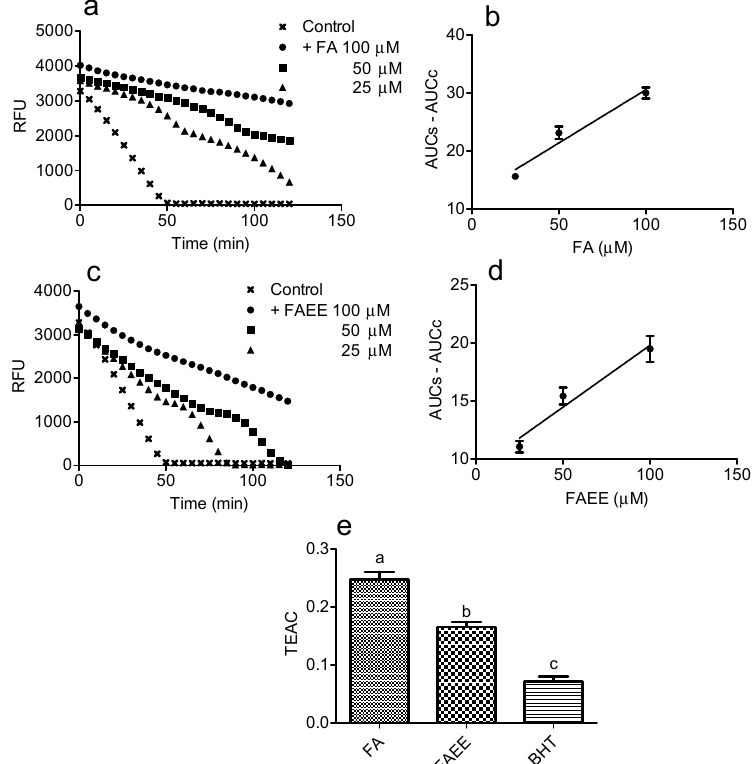
Figure 2. Scavenging activity against ROO•. ( a , c ) Kinetic profile of pyranine fluorescence bleaching by ROO• in the presence of absence of the tested compounds. ( b , d ) Linear relationship between the area under the curve and concentrations of FA and FAEE. From the liner regression curves the slopes were calculated. ( e ) Trolox equivalent antioxidant activity (TEAC = slope compound/slope trolox). The results are mean and SD of triplicate. Different letters denotes significant differences. One-Way Anova and Tukey’s Multiple Comparison Test ( p <